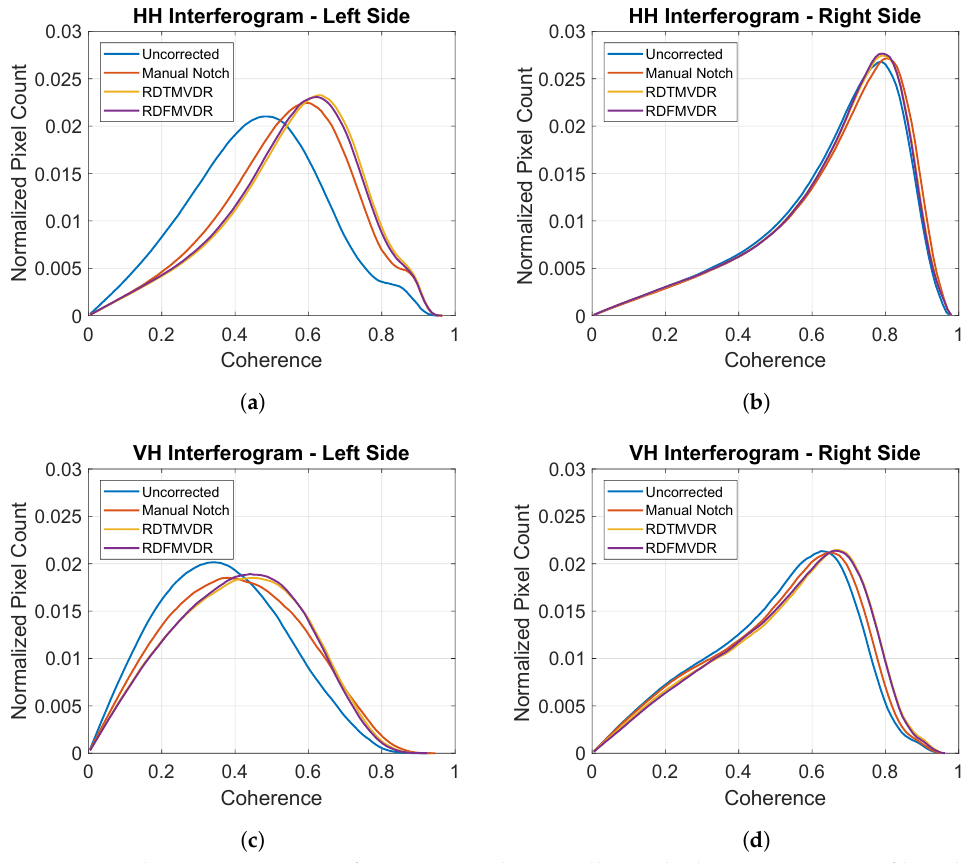
Figure 36. Coherence Histograms for uncorrected, manually notched, RD-Time MVDR filtered and RD-Frequency MVDR filtered image for ( a ) HH interferogram of left side, ( b ) HH interferogram of right side, ( c ) VH interferogram of left side, ( d ) VH interferogram of right side. The normalized pixel count values reported on the left axis indicate the ratio of the number of pixels with the given coherence value to the total number of